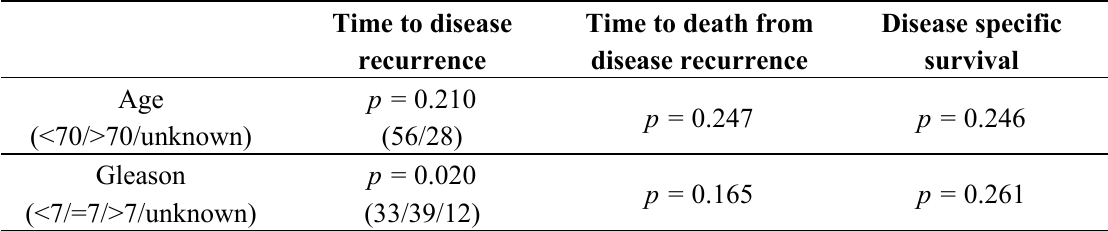
Table 1. Impact of clinicopathological factors on patient